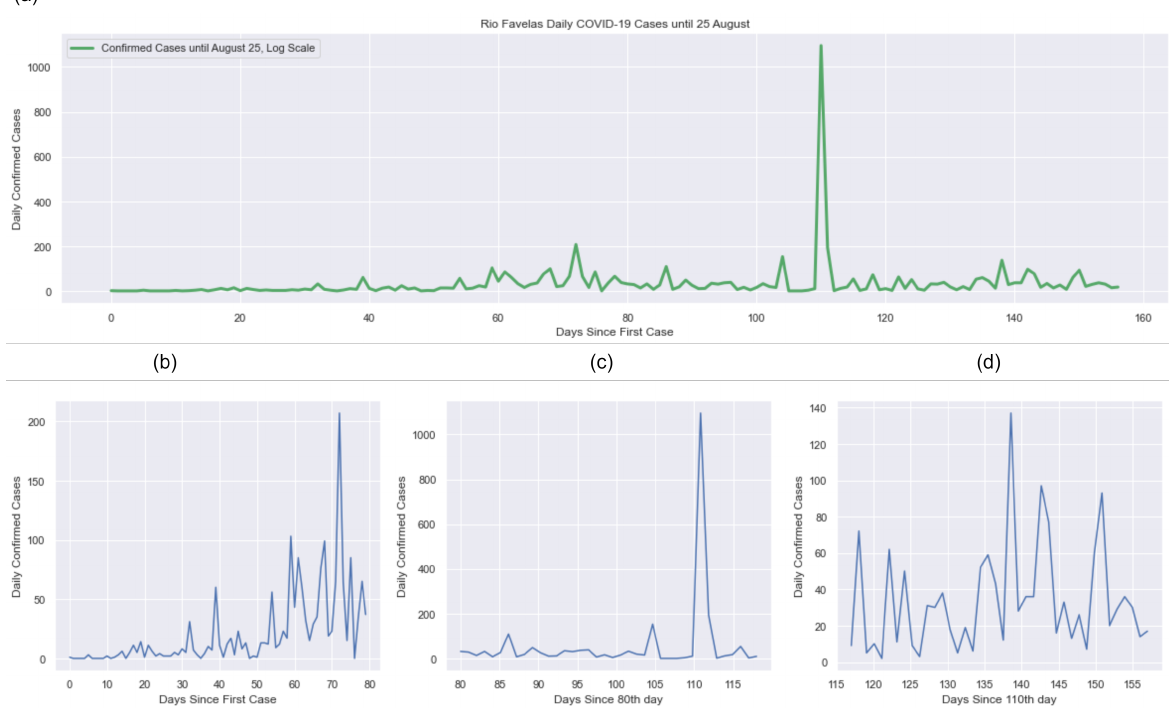
Figure 18. The different behaviors of COVID-19 evolution in Rio de Janeiro favelas, based on the time series of daily cases. (a) shows the entire series; (b) shows a window for the first 80 days since the first reported case, in this scenario it is possible to observe a progressive growth in the number of infections; (c) shows a window having an extreme peak of cases; and (d) shows a window that the time series presents similar behavior to the first 80 days, this shows that controlling the epidemic in the favelas is difficult, and this problem grows when there is an underreporting of cases and